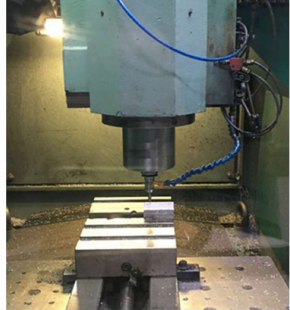
Figure 3. Workspace of the machine tool.